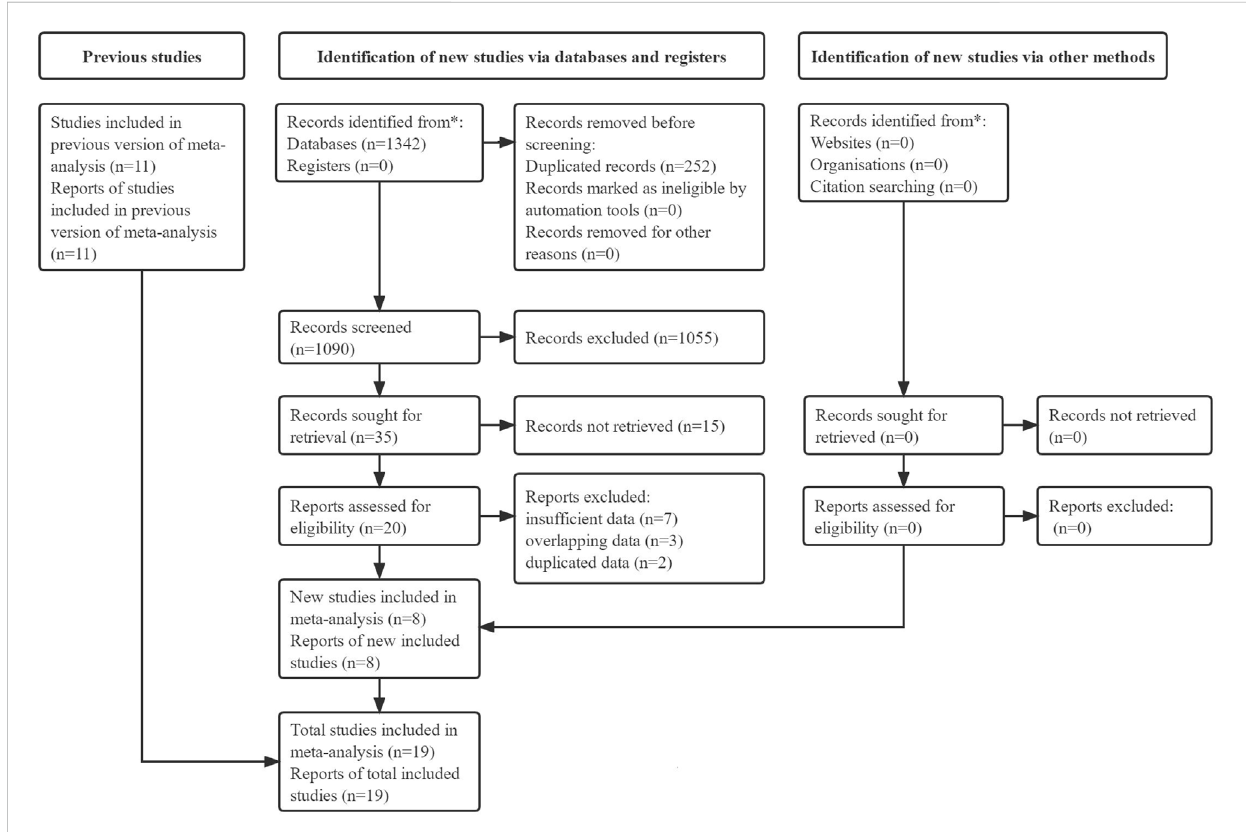
FIGURE 1 Flowchart of literature retrieval and inclusion in this